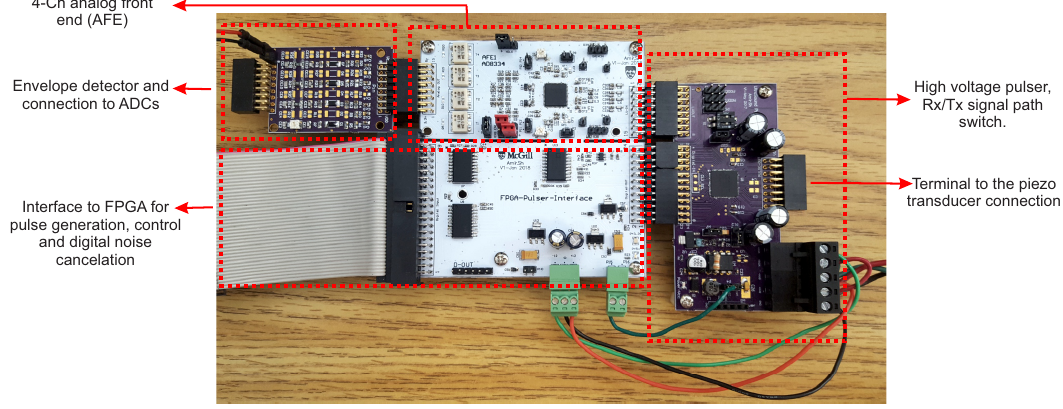
Figure 3. The designed 4-channel ultrasound system hardware setup consists of a high voltage pulser, an analogue front-end (AFE), an envelop detector and an ADC. It is interfaced with a Cyclone V FPGA board as a controller and data logger to the